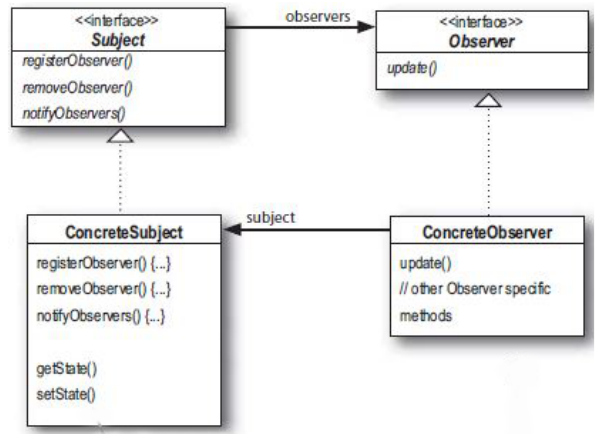
Fig. 3. Observer pattern UML diagram [4].